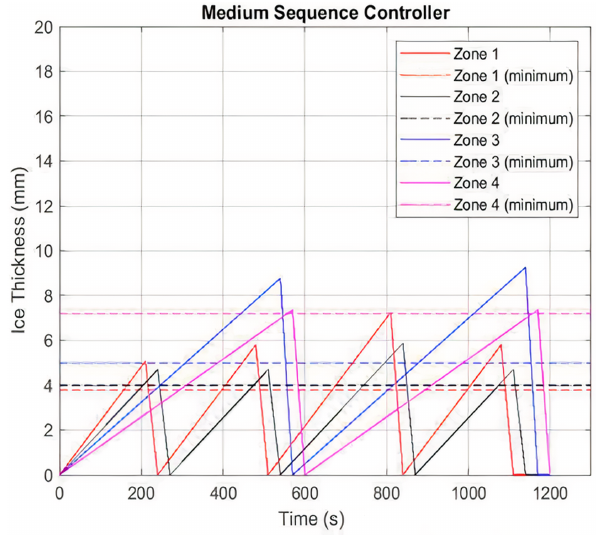
Figure 28. Repeatable time sequence for medium icing